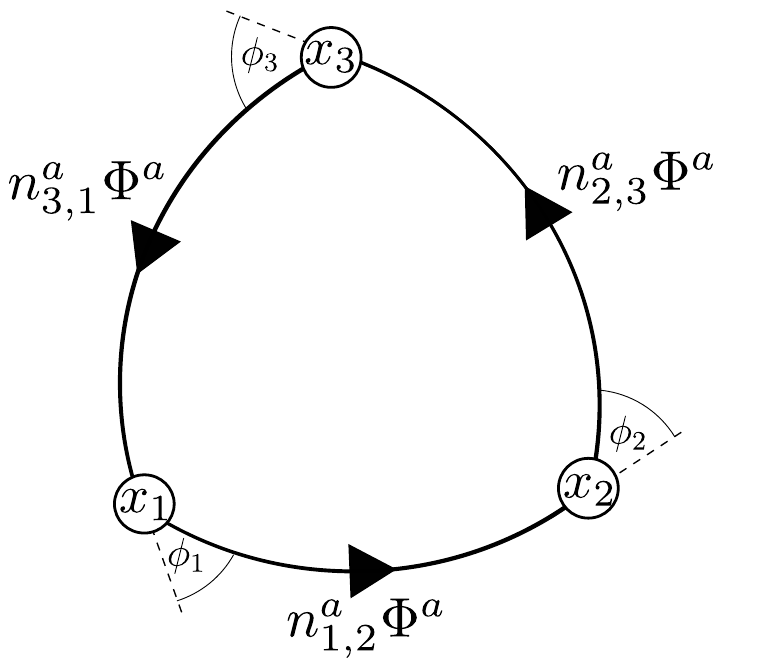
Figure 1 . The Wilson loop consisting of three circular arcs, with each arc’s respective (cid:12)eld cou- pling